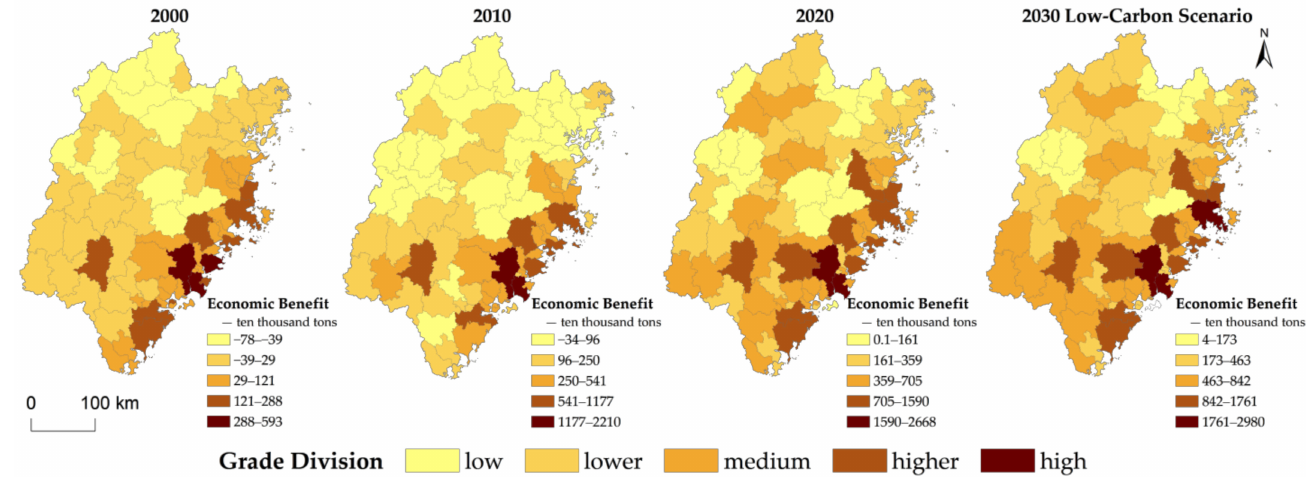
Figure 8. Spatial pattern evolution of land carbon emissions in Fujian